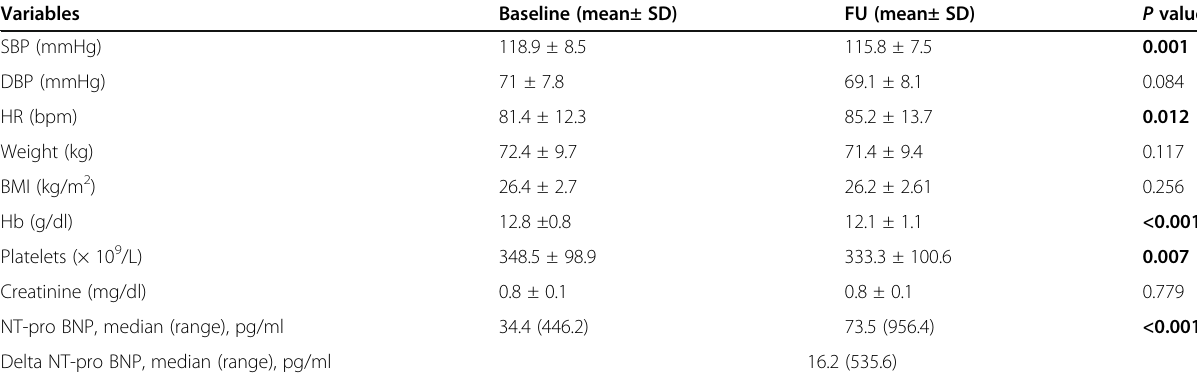
Table 2 Clinical parameters and laboratory results in the baseline and follow-up visits